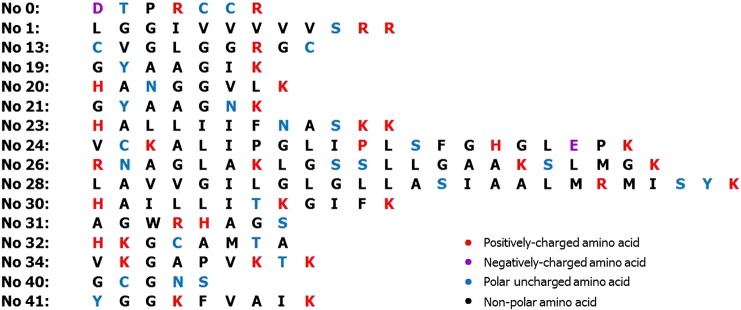
Amino acid constituents of 16 significantly predicted putative anticancer peptides from the F2 and F5 fractions of the A. fulica mucus. Colors represented amino acid properties as positively-charged, negatively-charged, polar and non-polar.